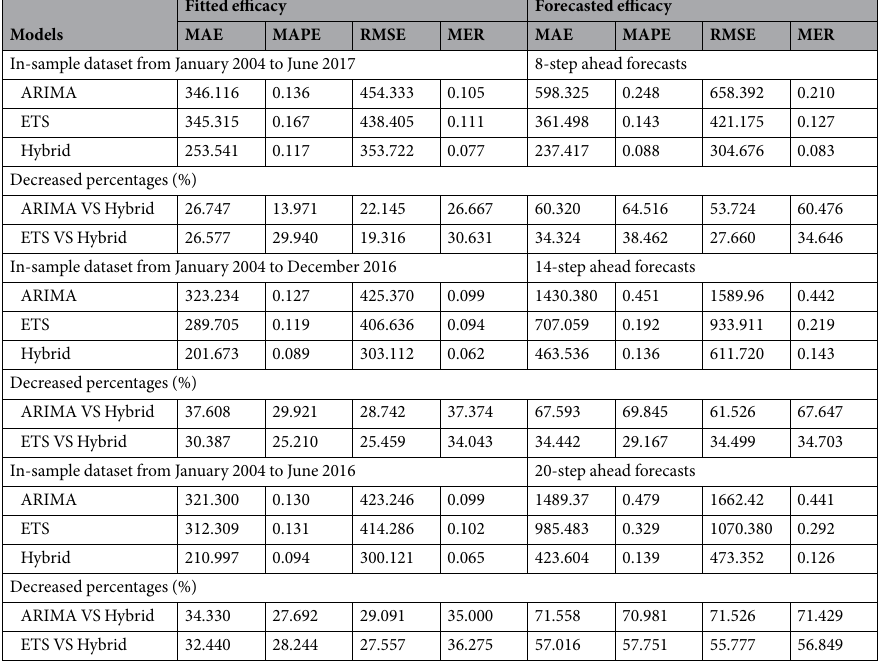
Fitted efficacy